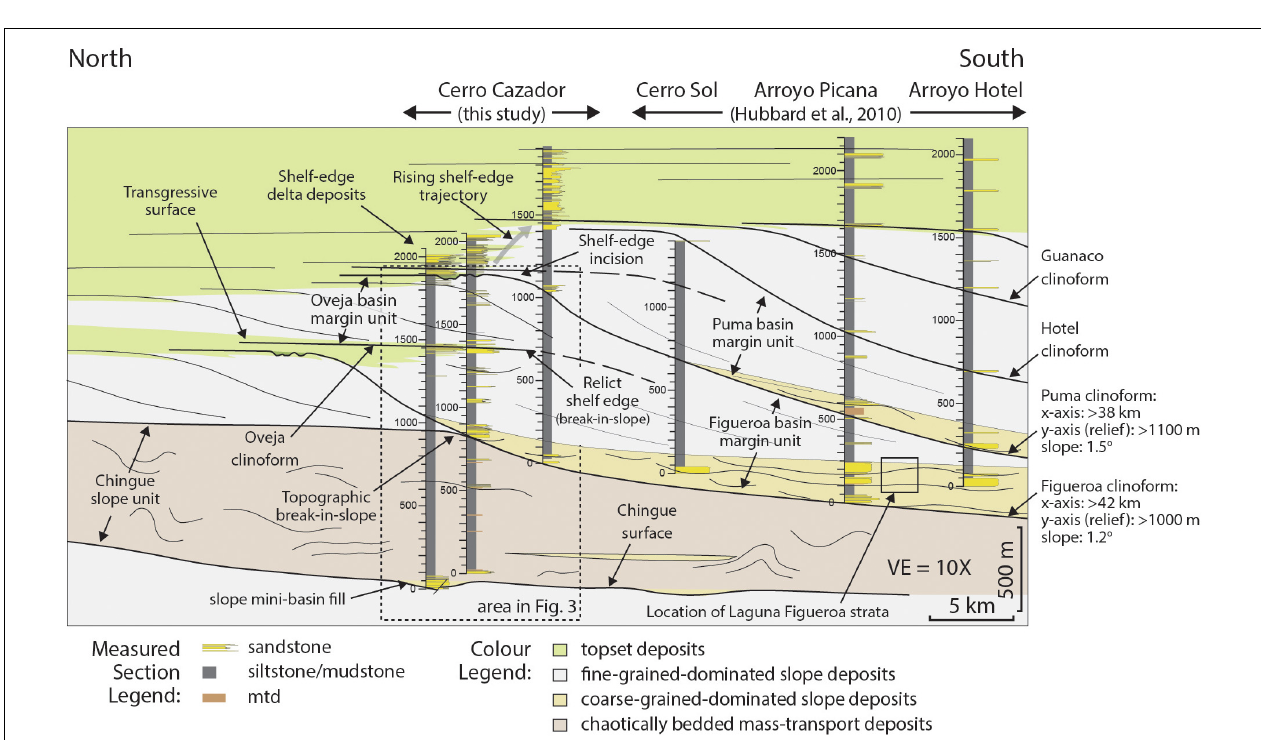
FIGURE 3 | Simplified depositional dip-oriented stratigraphic cross-section constructed from outcrop observations at Cerro Cazador (see Figures 2E , 4 for transect location). The main stratigraphic components and outcrop locations provide context for outcrop descriptions and interpretations. Note that thin vertical lines indicate locations of particularly long ( > 25 m) detailed measured sections. In general, sandstone-dominated strata are yellow and siltstone-dominated clinothem packages are gray; basal clinothem packages emphasized with a darker shade of gray. Thick, bold lines (red and dark gray) are interpreted clinoforms.